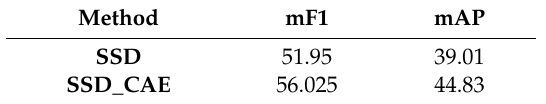
Table 4. Performance comparison of the SSD and SSD_CAE